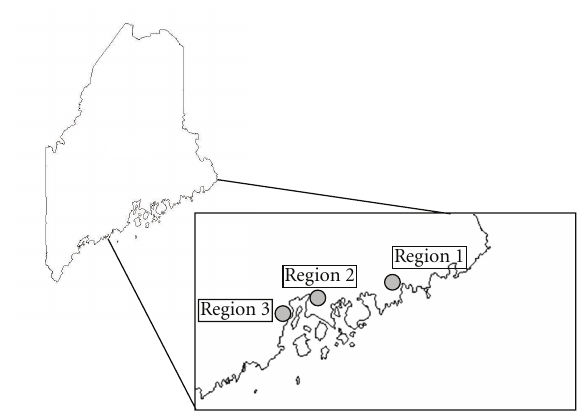
Figure 1: Map of the three lowbush blueberry regions in Maine in which the field sites are located: Region 1: 8 fields, Region 2: 8 fields + 1 unpaired field, and Region 3: 8